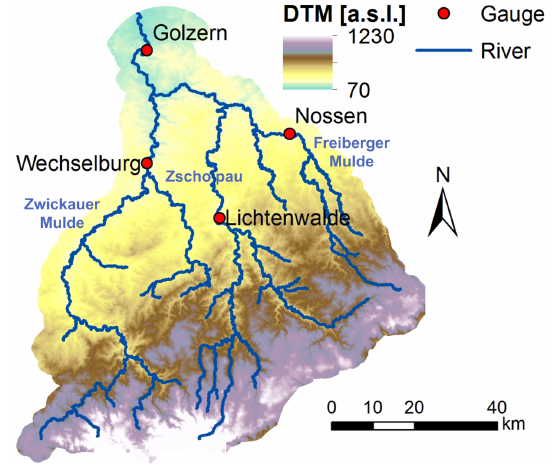
Figure 2. Position of gauging stations Wechselburg, Lichtenwalde and Nossen in the Mulde catchment.